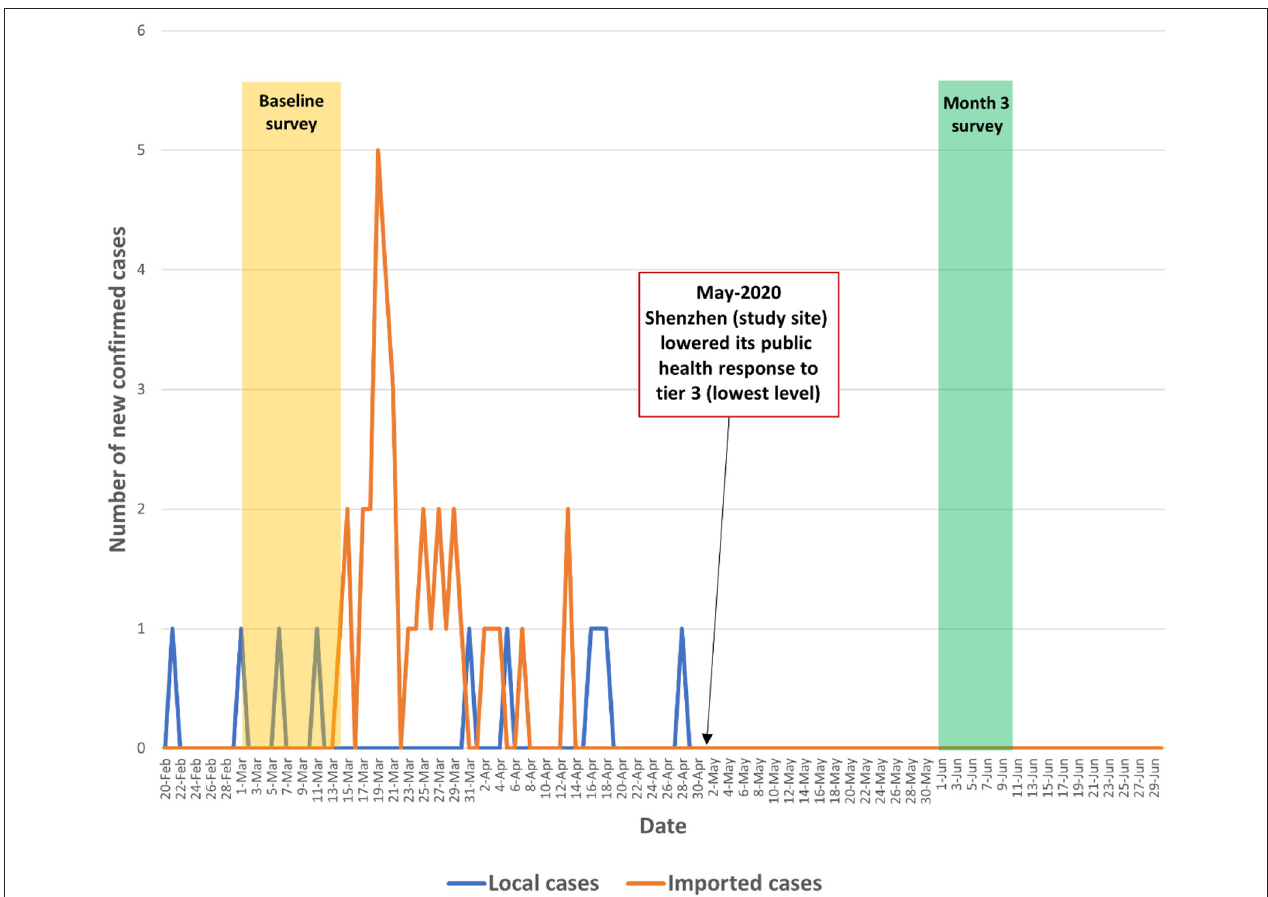
FIGURE 2 | Number of newly confirmed COVID-19 cases during the study period in Shenzhen (the study